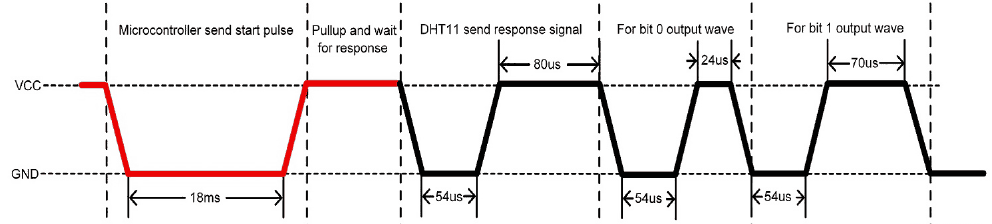
Figure 3. Communication cycle of the sensor.